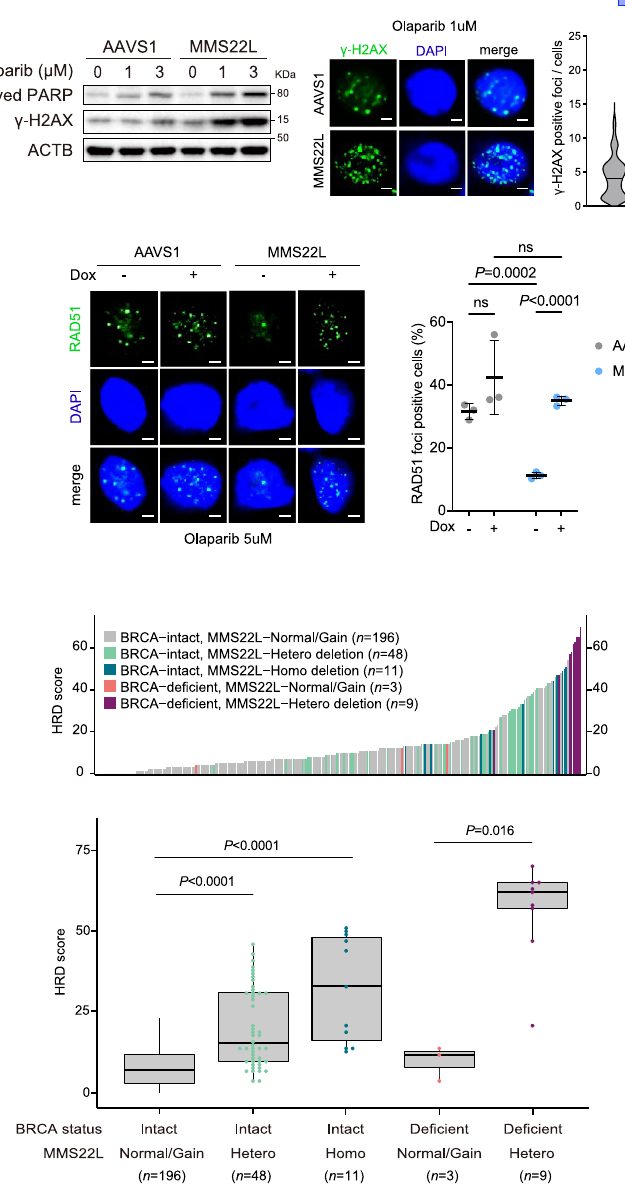
Nature Communications| (2023)